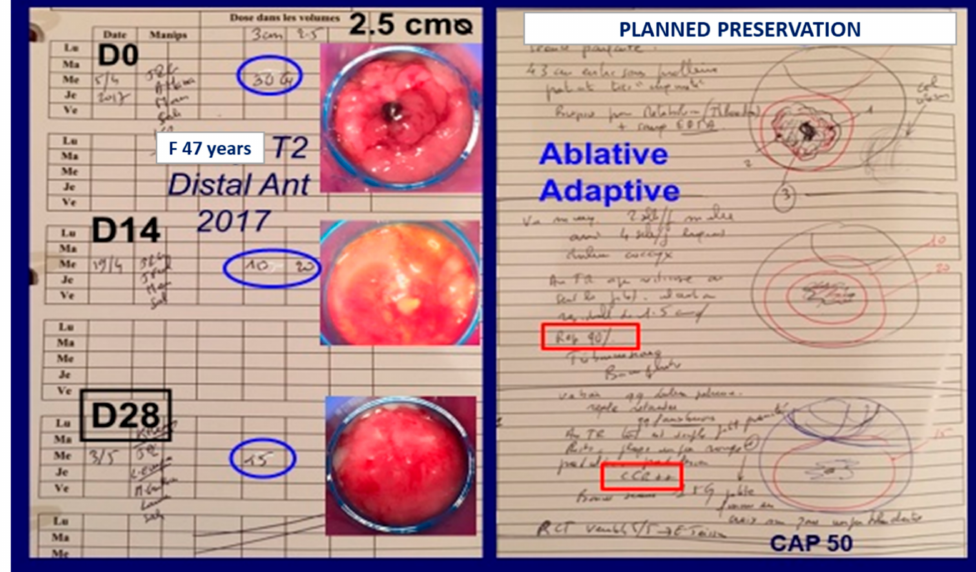
Figure 2. Illustration of tumor shrinkage during CXB treatment. Patient included (April 2017) in the OPERA trial in arm B1 (with CXB first). It was mainly an exophytic (polypoid) left-anterior tumor (knee–chest position: 5 to 8 o’clock). The rectoscope (blue) was 2.5 cm in diameter. Two weeks (D14) after 30 Gy (ablative dose) the tumor had shrunk by 95% and a small residual ulcer could be seen. The second fraction was given using two different applicators (adaptive strategy): a 3 cm diameter to deliver 10 Gy (in 40 s) and a second one 2.5 cm diameter delivering 20 Gy (in 1 min